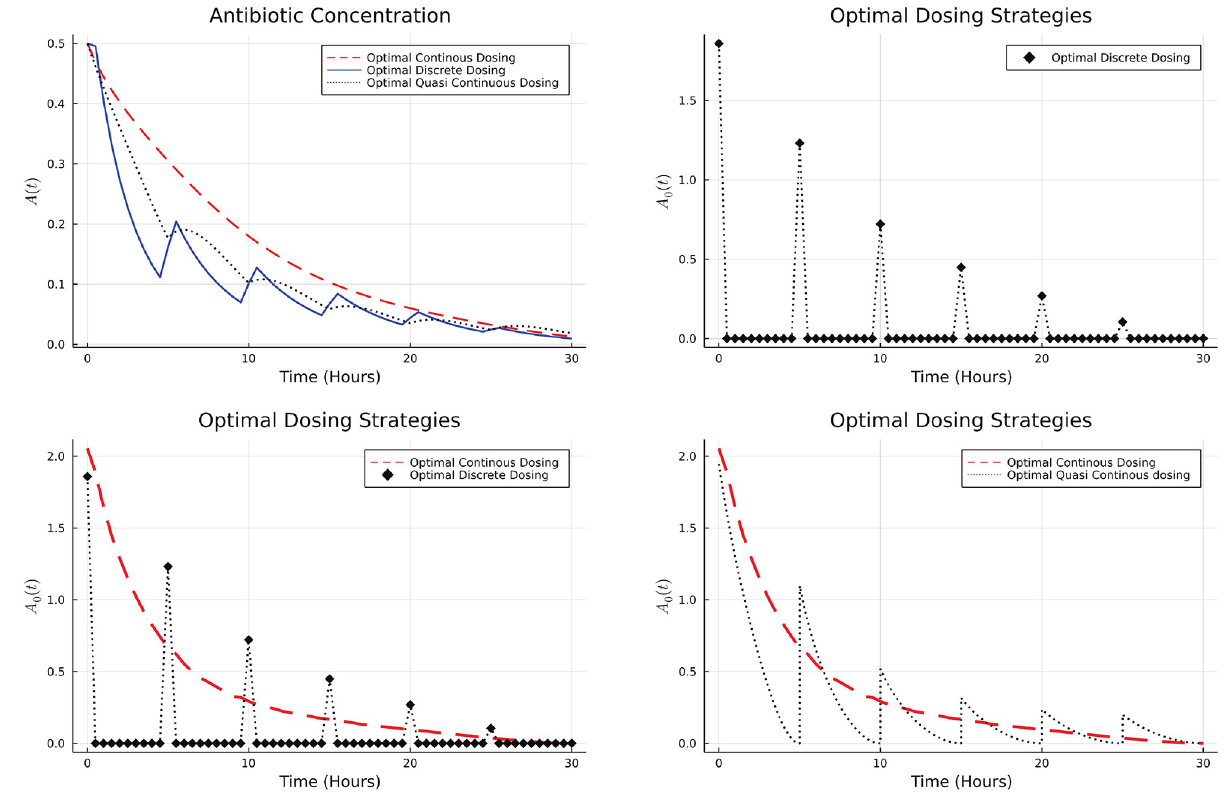
Fig 1. Optimal dosing strategies and bacterial population.